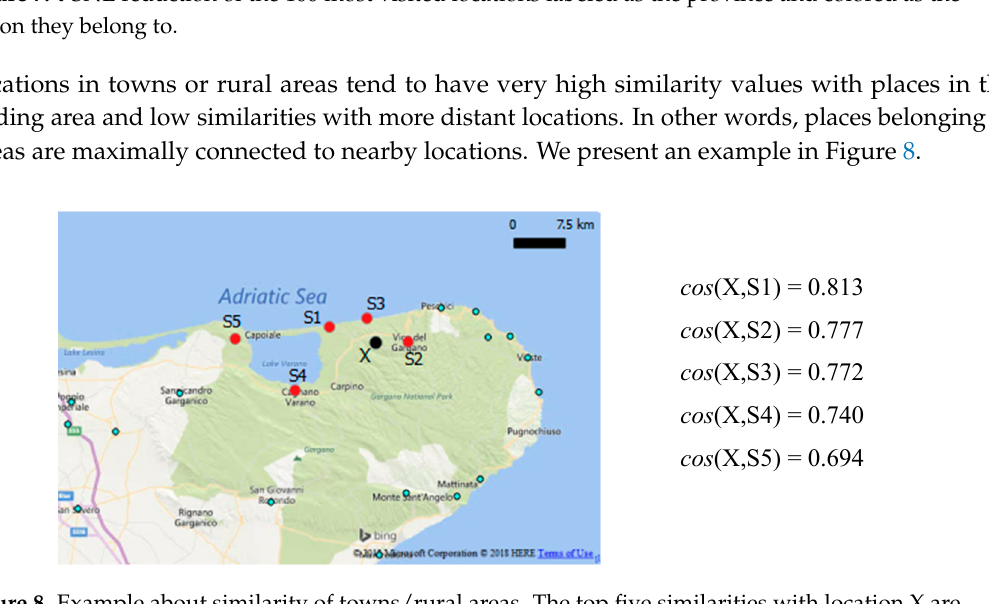
Figure 8. Example about similarity of towns/rural areas. The top five similarities with location X are reported: high similarities tend to distribute over the local area surrounding location X.